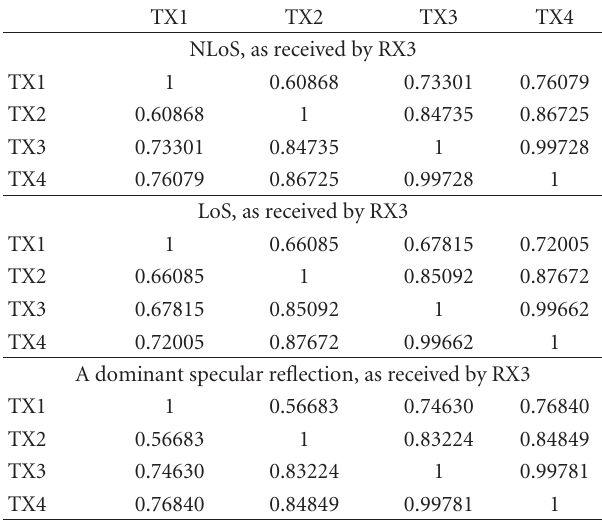
Table 5: Signal envelope correlation of the transmitted